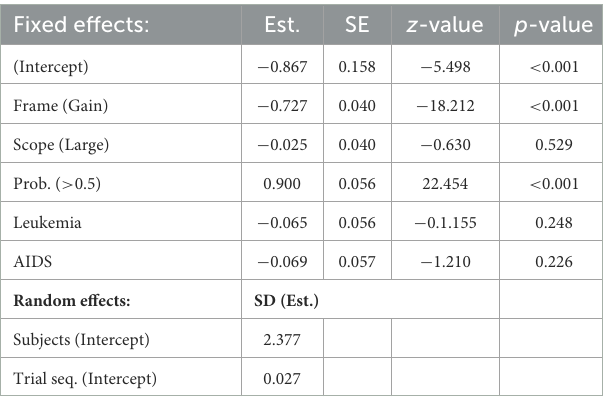
TABLE 5 Experiment 2: Main effects